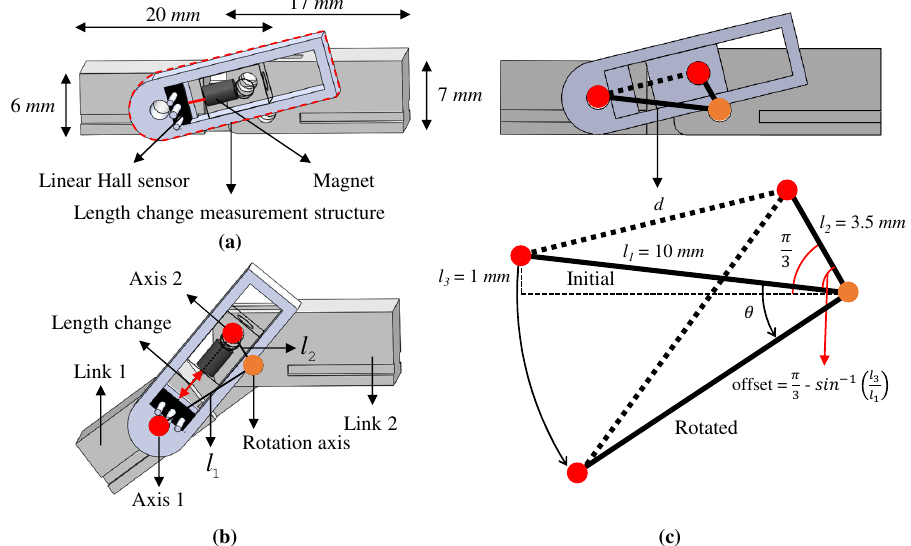
Figure 3. Design of rotation measurement structure; ( a ) Initial position; ( b ) Rotated position; ( c ) Calculation of rotation